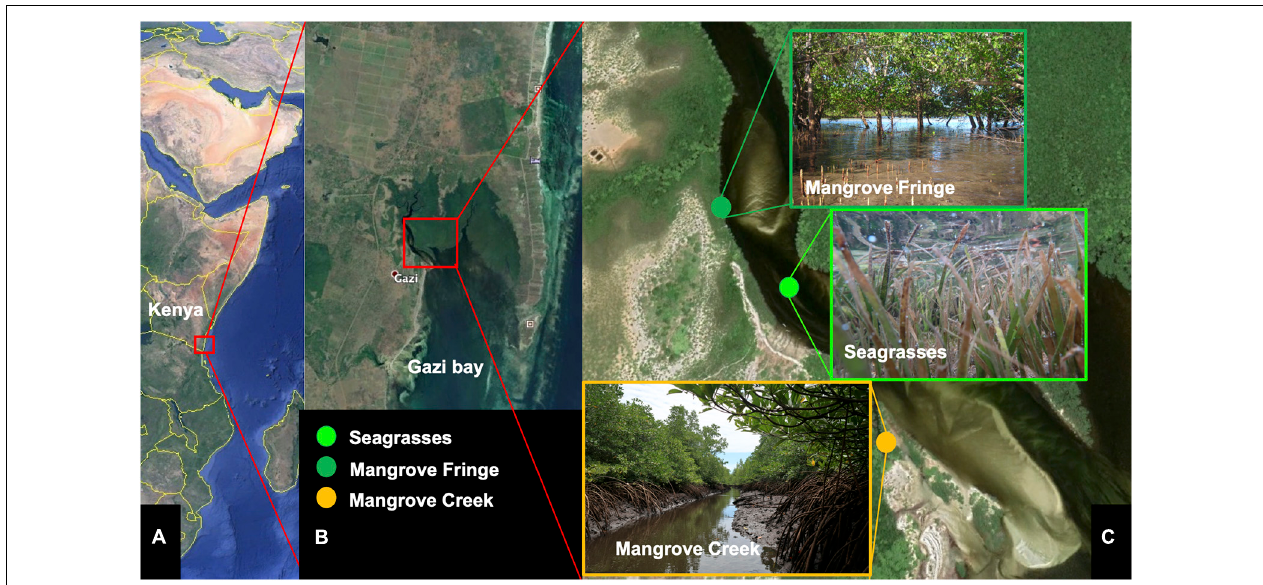
FIGURE 1 | The equatorial study site was Gazi Bay (Kenya) (A) with three habitats where the study species Thalamita crenata occurs, (B) the mangrove fringe opening onto the main channel of the forest, the seagrasses growing in the channel and the seaward subtidal area and the mangrove creek (C) . Photo Credit in panel (C) :